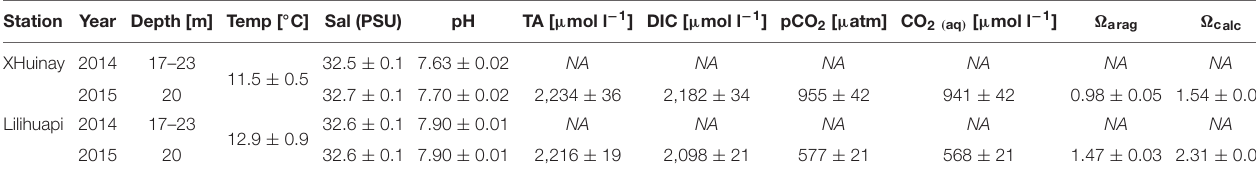
FIGURE 2 | Environmental parameters of Comau Fjord (2014–2015). (A) Average pH (17–23 m water depth; February 2014) throughout the fjord (end–mouth), resolved from six CTD casts at different stations within the fjord, including the two experimental stations XHuinay (red) and Lilihuapi (blue). (B) Monthly average water temperature (January 2014–February 2015) at a depth of 20 m at the two experimental sites. Dots refer to the monthly means, the shaded areas to the variation between minimum and maximum temperature during the respective month. (C) Salinity at the two experimental sites from the surface to 30 m depth (February 2014); XHuinay = red and Lilihuapi = blue. TABLE 1 | Physical parameters and carbonate